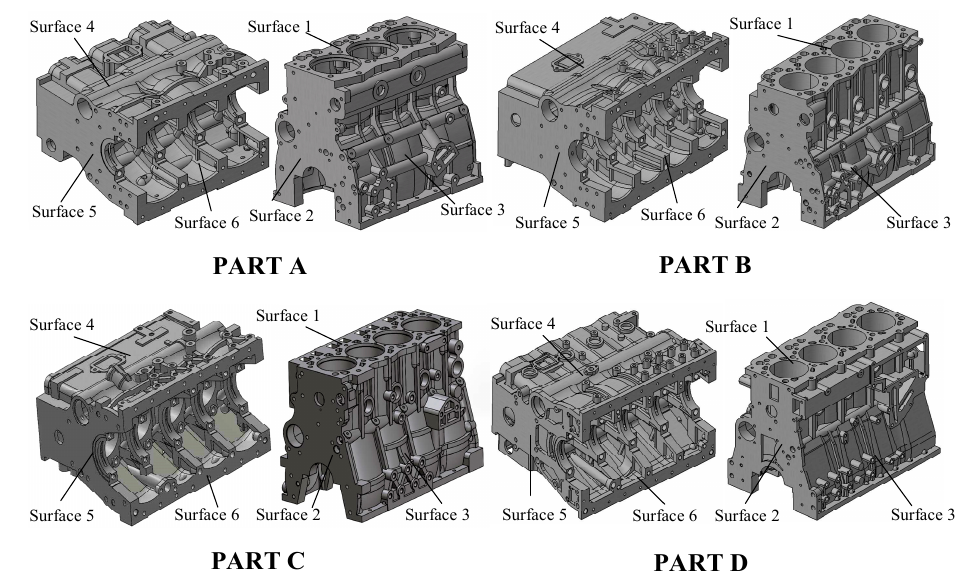
Figure 1. Three-dimensional model of the four kinds of engine blocks.